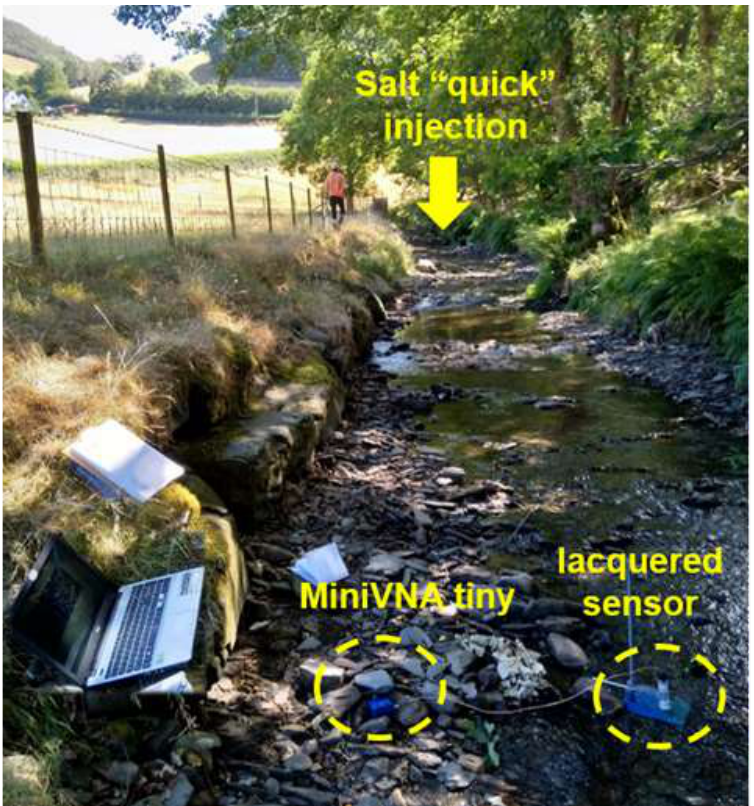
Figure 7. Evaluation of the feasibility to measure “unexpected” variation in a parameter (NaCl in this case) in freshwater and the return to the baseline level.